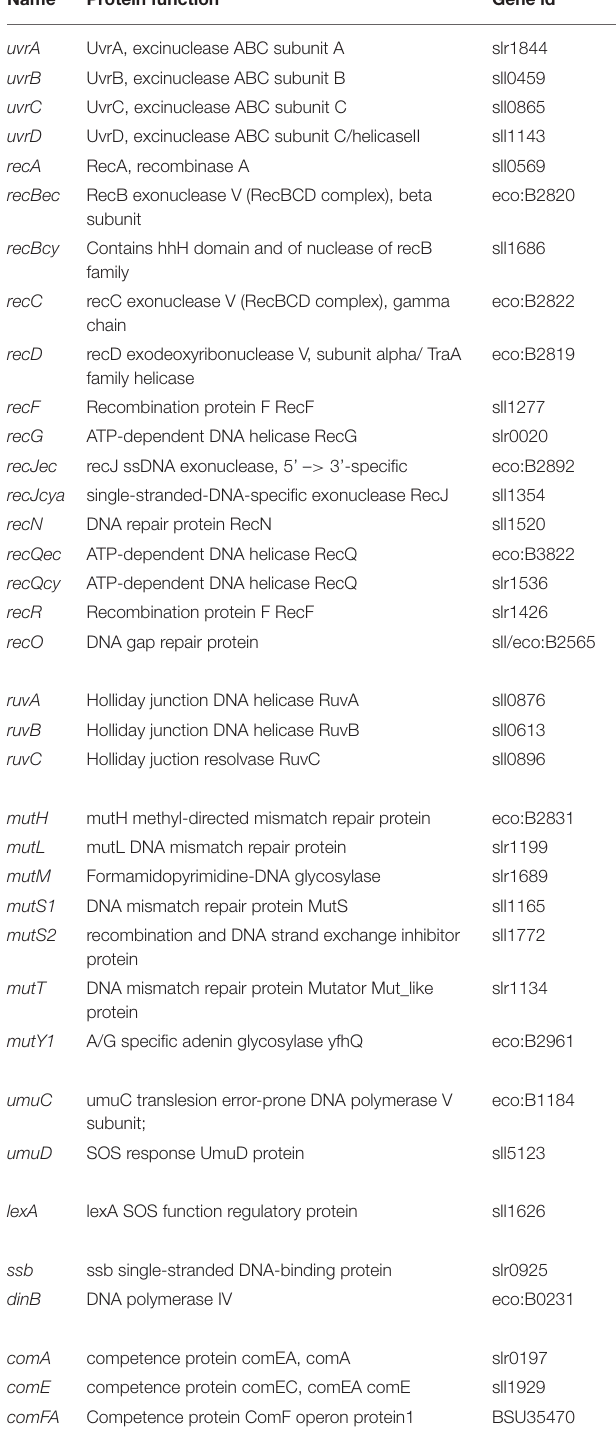
TABLE 1 | Reference of the genes from Synechocystis PCC6803 (sll or slr), E.coli (eco) or B.subtilis (BSU) in the MBGD data base (http://mbgd.genome.ad.jp/) used for searching their homologs in the studied